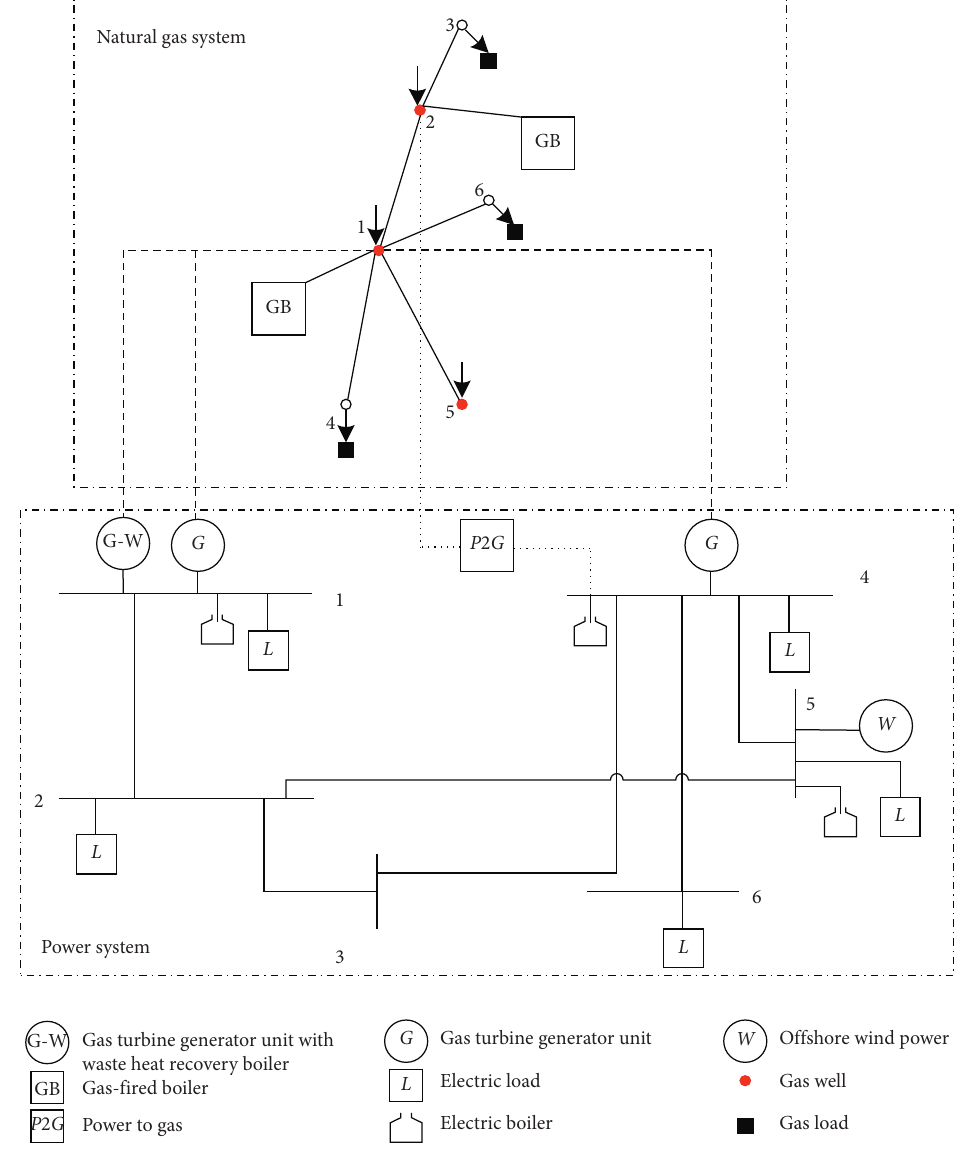
Figure 2: A case of